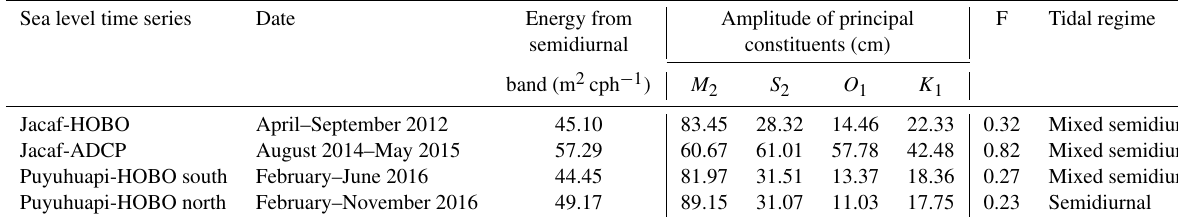
Table 2. Harmonic analysis implemented to water level time series in Puyuhuapi Fjord and Jacaf Channel. Sea level time series